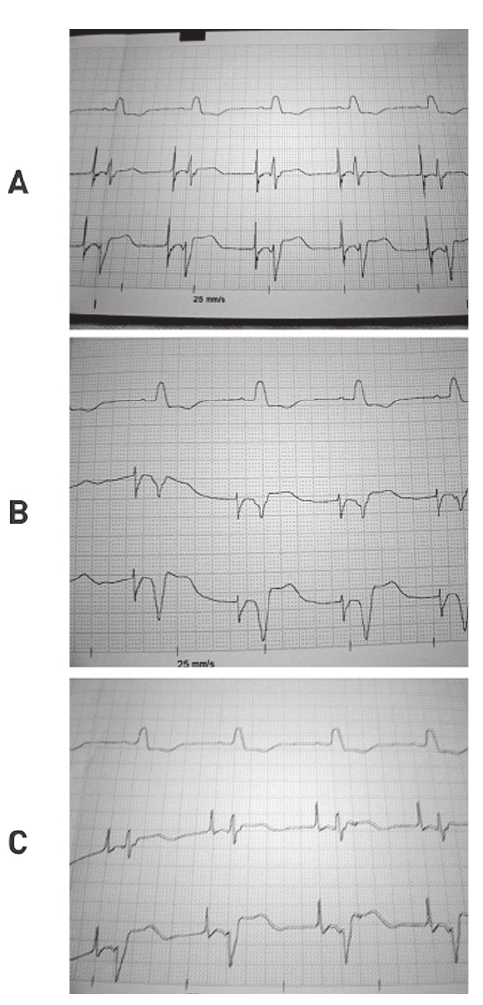
Fig. 3 - Registro com três traçados. O traçado superior evidenciando eletrocardiograma de superfície em 25 mm/s. Os traçados inferiores evidenciando eletrogramas intracavitários unipolares obtidos durante o procedimento, com o eletrodo posicionado em região pôstero-septal direita. (A) Eletrograma intracavitário obtido no óstio do seio coronário. (B) Eletrograma obtido, próximo, porém em regiões mais posteriores ao óstio do seio coronário. (C) Eletrograma obtido próximo, porém em regiões mais anteriores ao óstio do seio